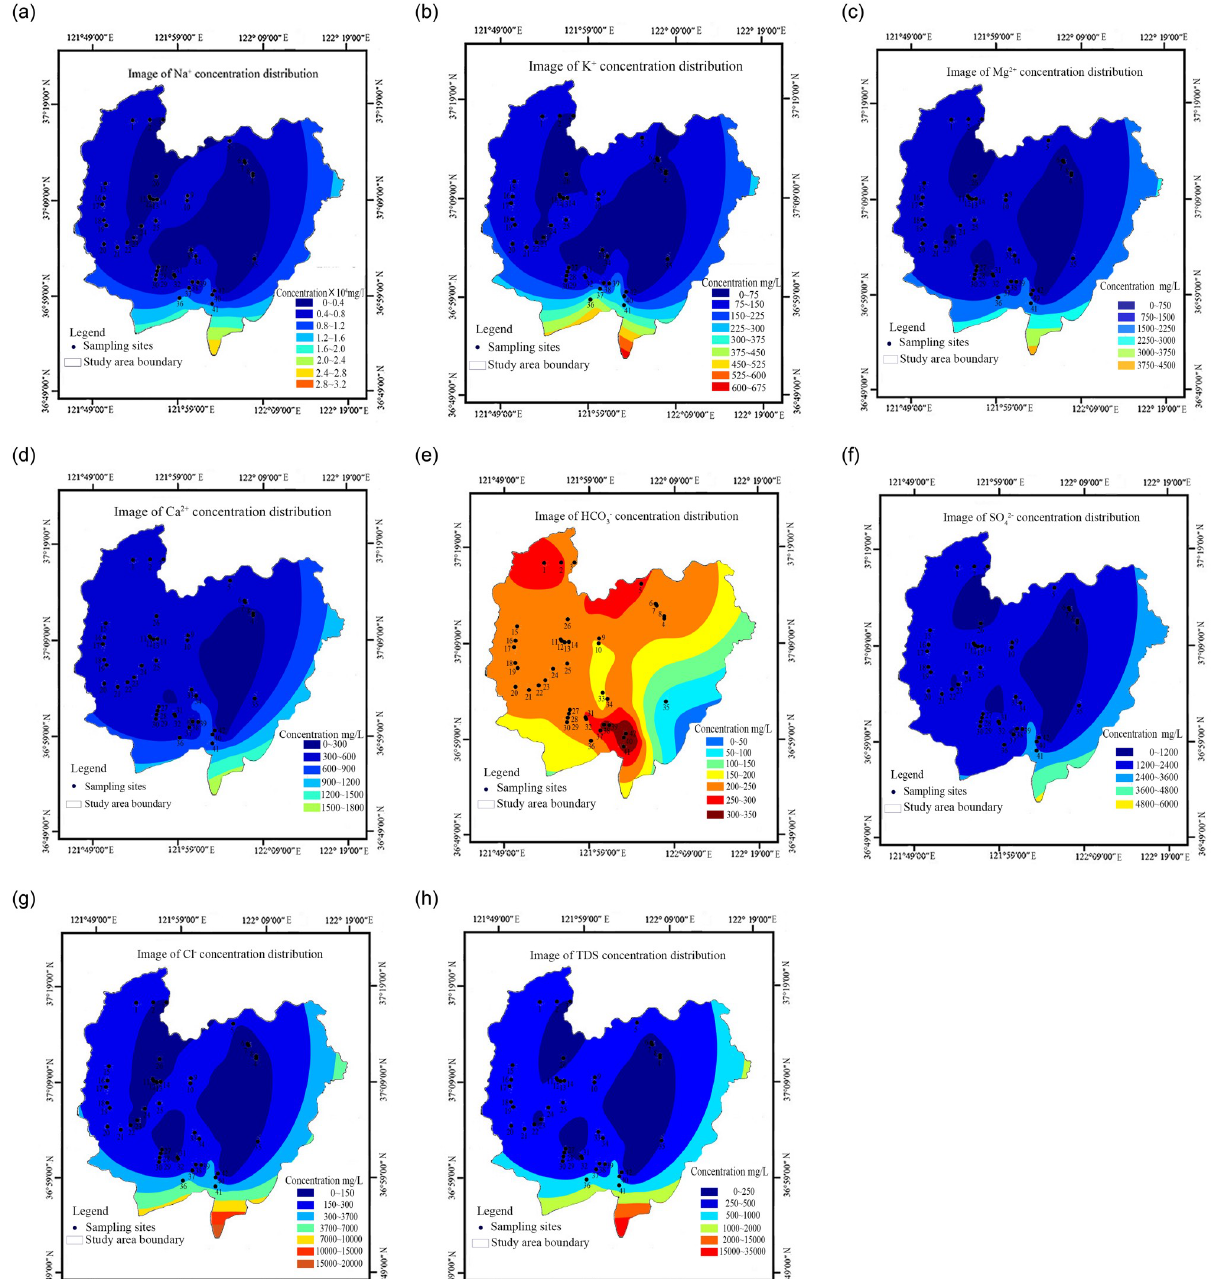
Fig 3. Images of main ion concentration